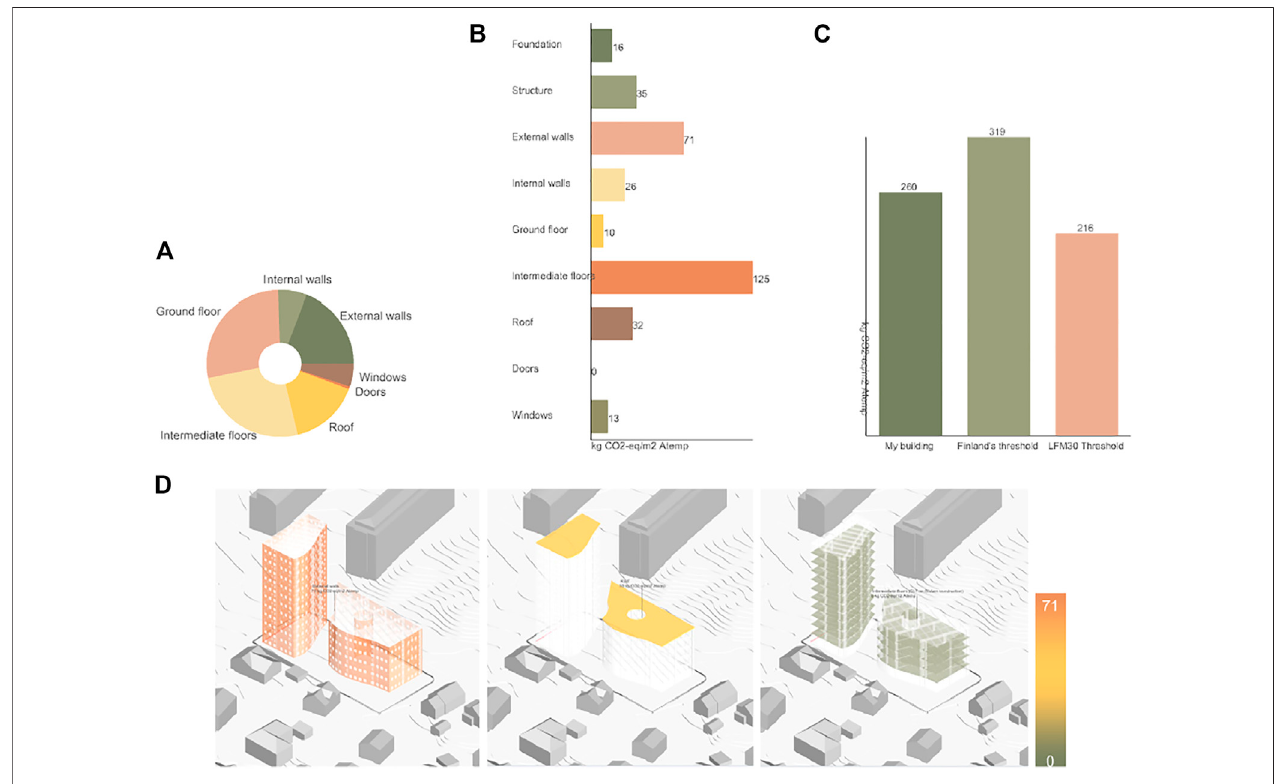
FIGURE 6 | Visualization types in the tool (A) pie chart of the impact of each element, (B) bar chart of the impact of each element (C) comparison with reference values, (D) color-coded 3D model showing GWP of different elements in kg CO 2 -e/m 2 .